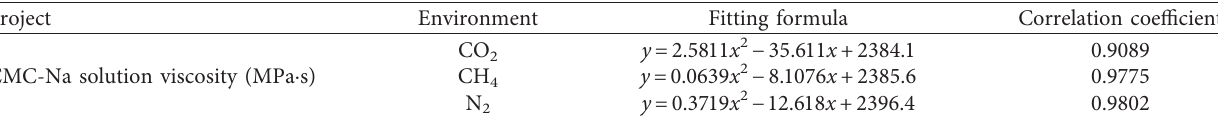
Table 5: Fitting formula of the viscosity of CMC-Na prepared using distilled water at different pressures. Project